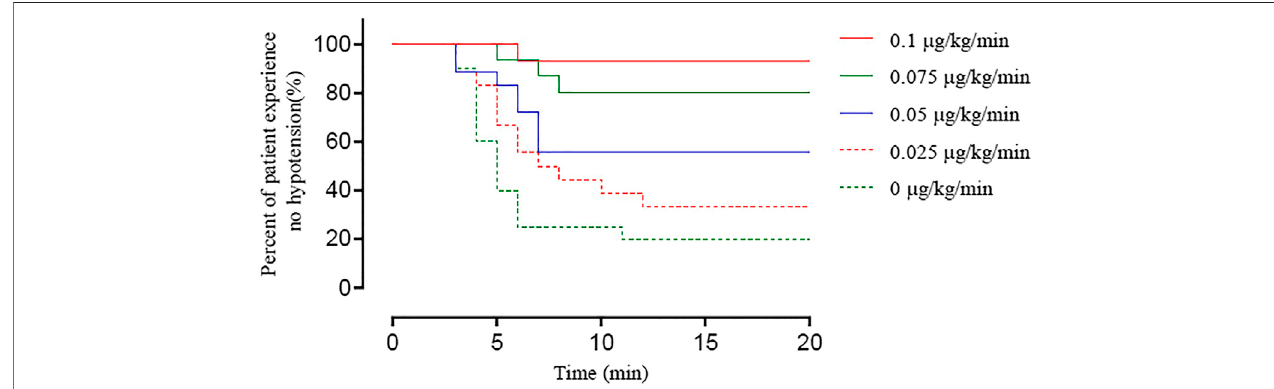
FIGURE4| Kaplan – MeiersurvivalcurvesshowingthepercentageofpatientswhoseSBPremained > 80%ofbaselineor ≥ 90 mmHguntilnewborndelivery.There was a signi fi cant difference among groups (log-rank test, p < 0.0001).